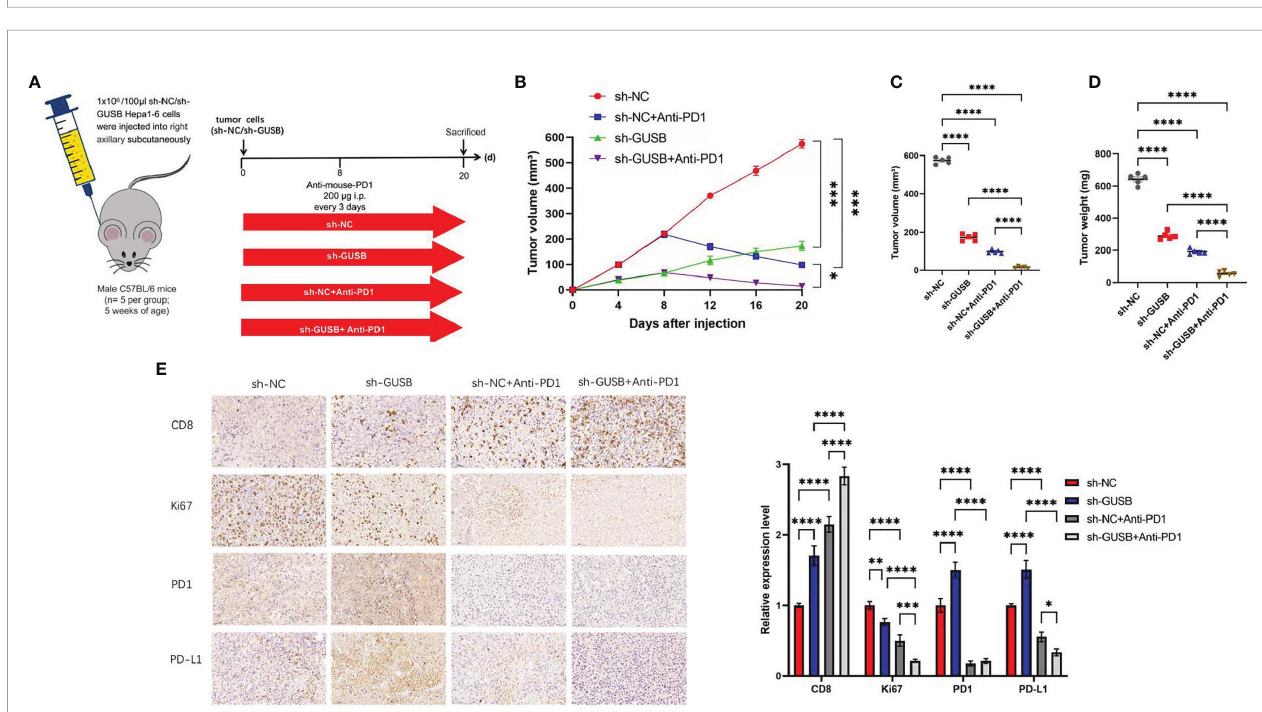
FIGURE 4 | Knocked down of GUSB upregulated PD-L1 expression by decreasing miR-513a-5p expression. (A – E) qRT-PCR results of the changes of miRNAs caused by sh-GUSB to HCC cells. (F) qRT-PCR results for PD-L1 in HCC cells. * P < 0.05; ** P < 0.01; *** P < 0.001; **** P < 0.0001.